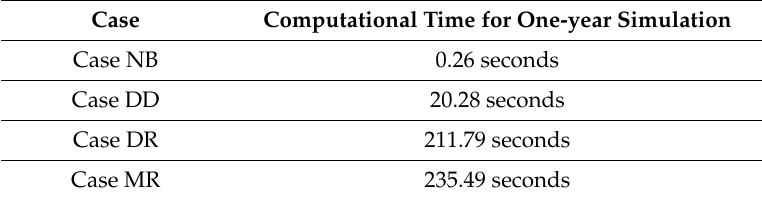
Table 2. Computational times for di ff erent optimisation strategies.